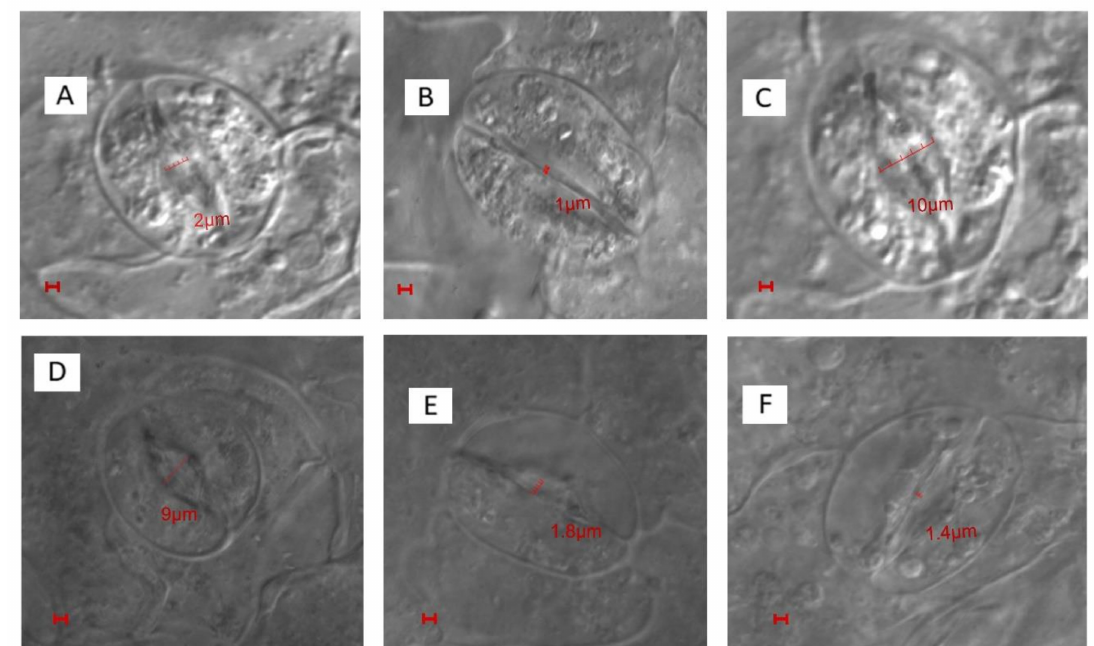
Figure 5. Stomatal behavior of mustard leaves ( A ) under control, ( B ) 100 mM NaCl, ( C ) 200 mg S kg − 1 soil + 200 µ L L − 1 ethephon without NaCl, ( D ) 200 mg S kg − 1 soil + 200 µ L L − 1 ethephon with NaCl, ( E ) 100 µ M norbornadiene (NBD), and ( F ) 100 µ M norbornadiene (NBD) in presence of 100 mM NaCl with 200 mg S kg − 1 soil + 200 µ l L − 1 ethephon at 30 days after sowing. The stomatal opening and closing response was studied using confocal microscopy. Bars = 1 µ